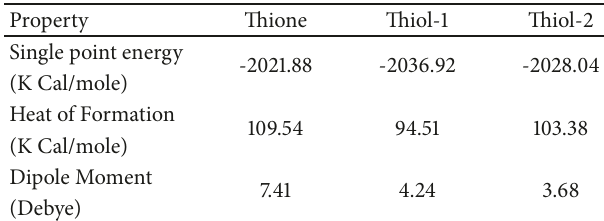
Table 1: Molecular properties of